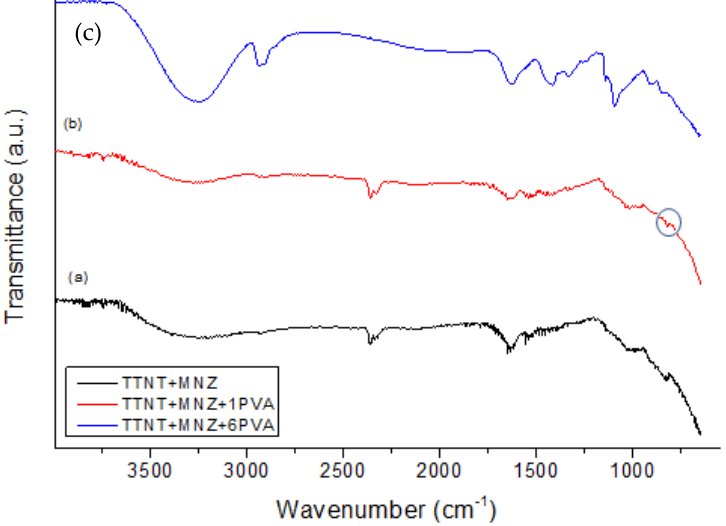
Figure 9. FTIR spectra of TTNT samples loaded with metronidazole: (a) TTNT + MNZ, (b) TTNT + MNZ + 1PVA and (c) TTNT + MNZ + 6PVA.